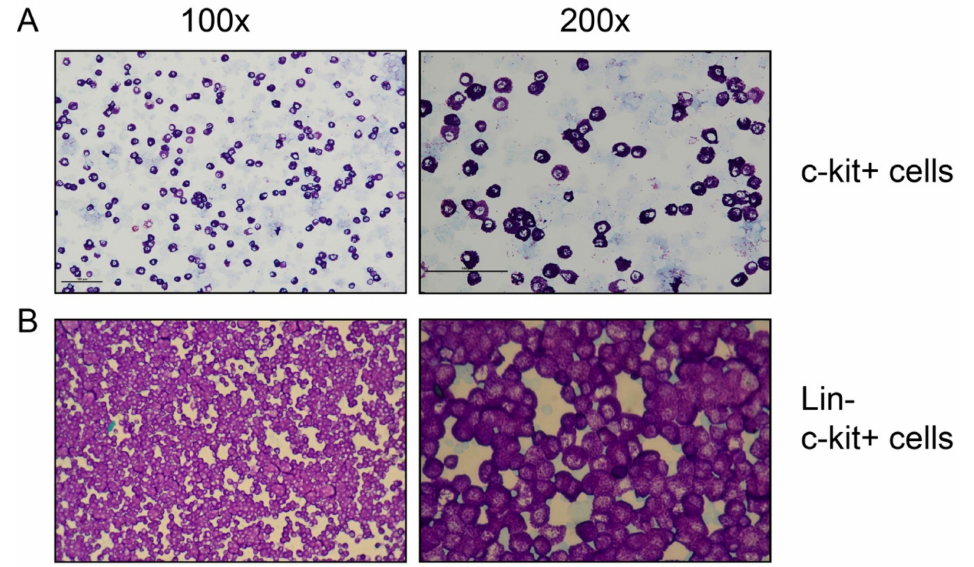
Figure 1. Toluidine blue staining of MACS-separated peritoneal cells. MACS-separated cells were spun onto glass slides by cytospin centrifugation and were stained with toluidine blue. ( A ) the c-kit + cells from the first purification. ( B ) the Lin − / ckit + cells from the second, purer, preparation. Both were used for the transcriptome